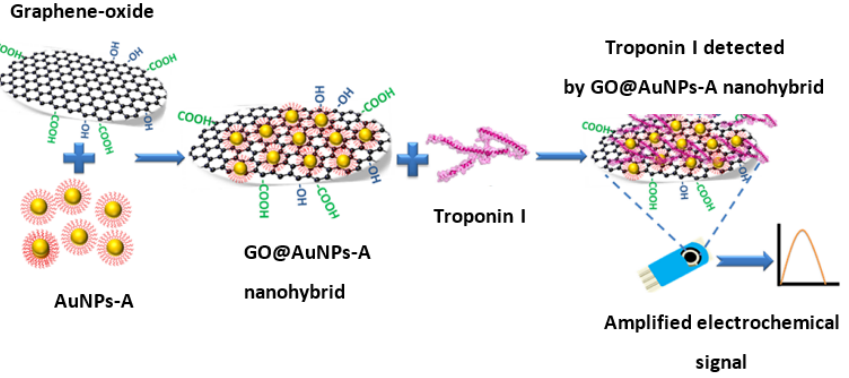
Figure 6. Synthesis of graphene oxide (GO) aptamer-functionalized gold nanoparticles (AuNPs-A) nanocomposite and mechanism of electrochemical detection of troponin I. Adapted with permission from Kakkar et al. [71]. Copyright © (2023), Elsevier.